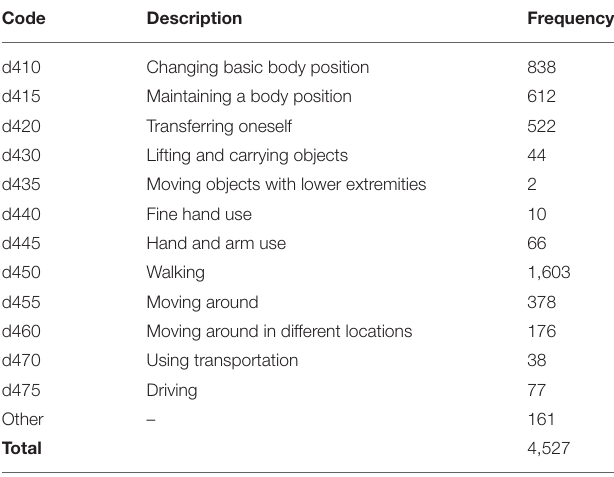
TABLE 1 | ICF code descriptions and frequencies in physical therapy notes